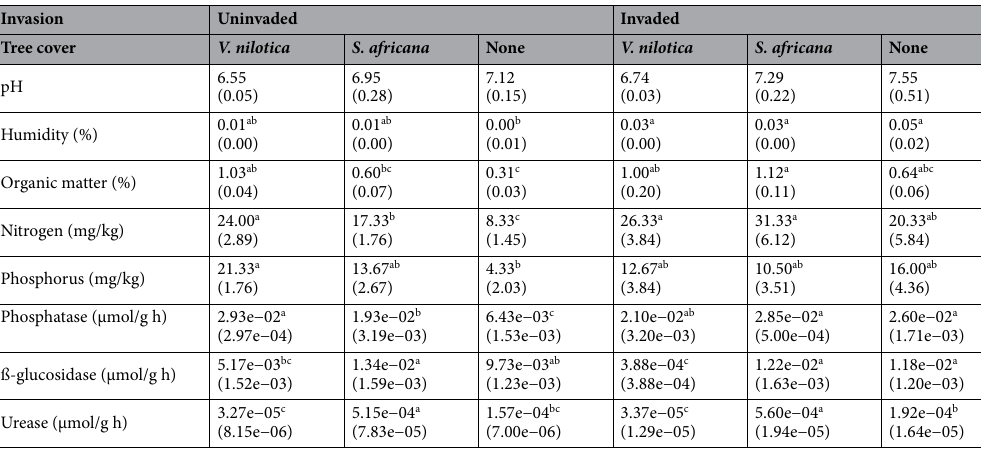
Table 1. Mean (± SE) of pH, humidity (%), organic matter (%), nitrogen (mg/Kg), phosphorus (mg/Kg), phosphatase activity (µmol/g h), β-glucosidase activity (µmol/g h) and urease activity (µmol/g h) in patches invaded and uninvaded by O. stricta under the canopies of V. nilotica and S. africana and in open patches with no tree cover. Letters indicate significant differences between soils (P <